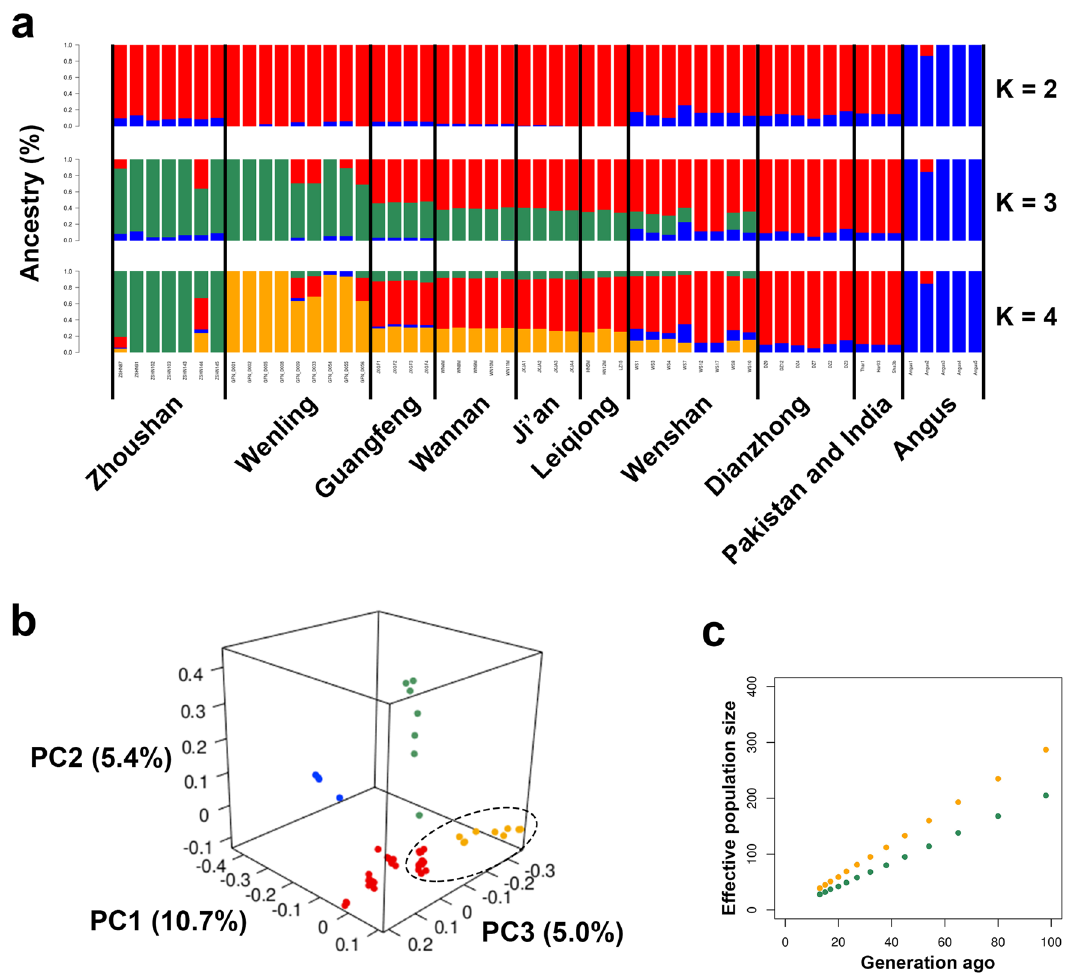
Figure 2. Admixture and principal component analysis of Zhoushan cattle and other cattle breeds. ( a ) Admixture plot (K = 2, 3, 4) for the 54 cattle individuals. Each individual is shown as a vertical bar divided into K colours. ( b ) PCA plot showing the genetic structure of the 54 cattle individuals. The degree of explained variance is given in parentheses. Colours reflect the geographic regions of sampling in Fig. 1d. The cluster composed of cattle in Wenling, Guangfeng, Wannan, Ji’an, and Leiqiong is highlighted in the black dotted ellipse. ( c ) Estimate of the effective population sizes of Zhoushan (green) and Wenling (orange) cattle over the past 100